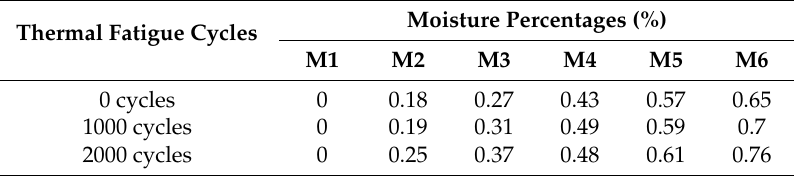
Table 2. Specimens subjected to different thermal fatigue and moisture diffusions.